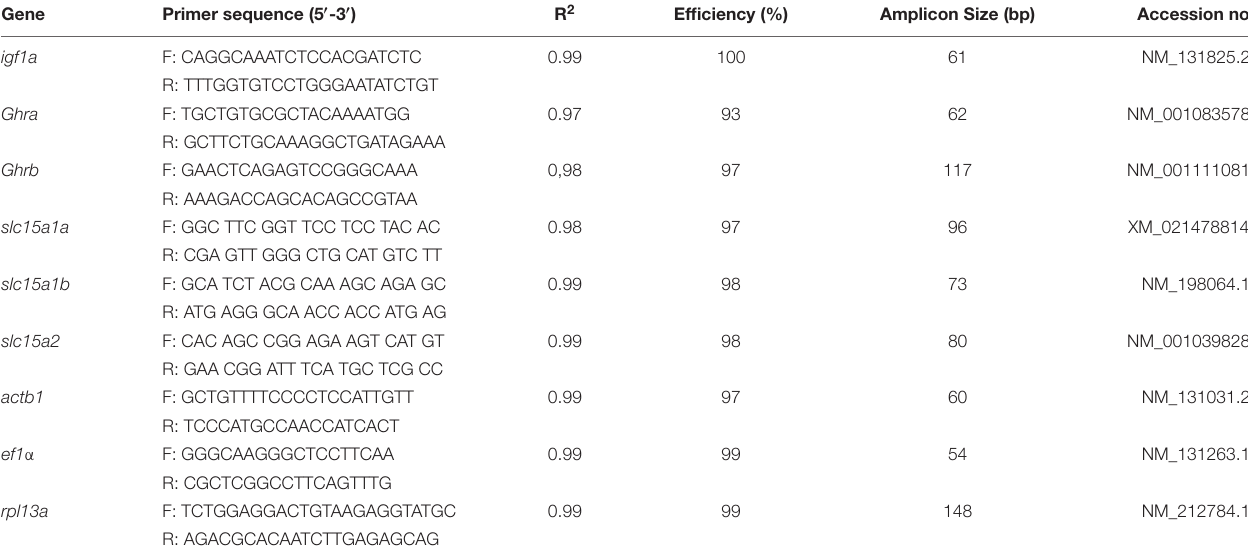
TABLE 1 | Gene-specific primers were used for quantitative reverse transcription polymerase chain reactions (qRT-PCR). Gene Primer sequence (5 (cid:48) -3 (cid:48) ) R 2 Efficiency (%) Amplicon Size